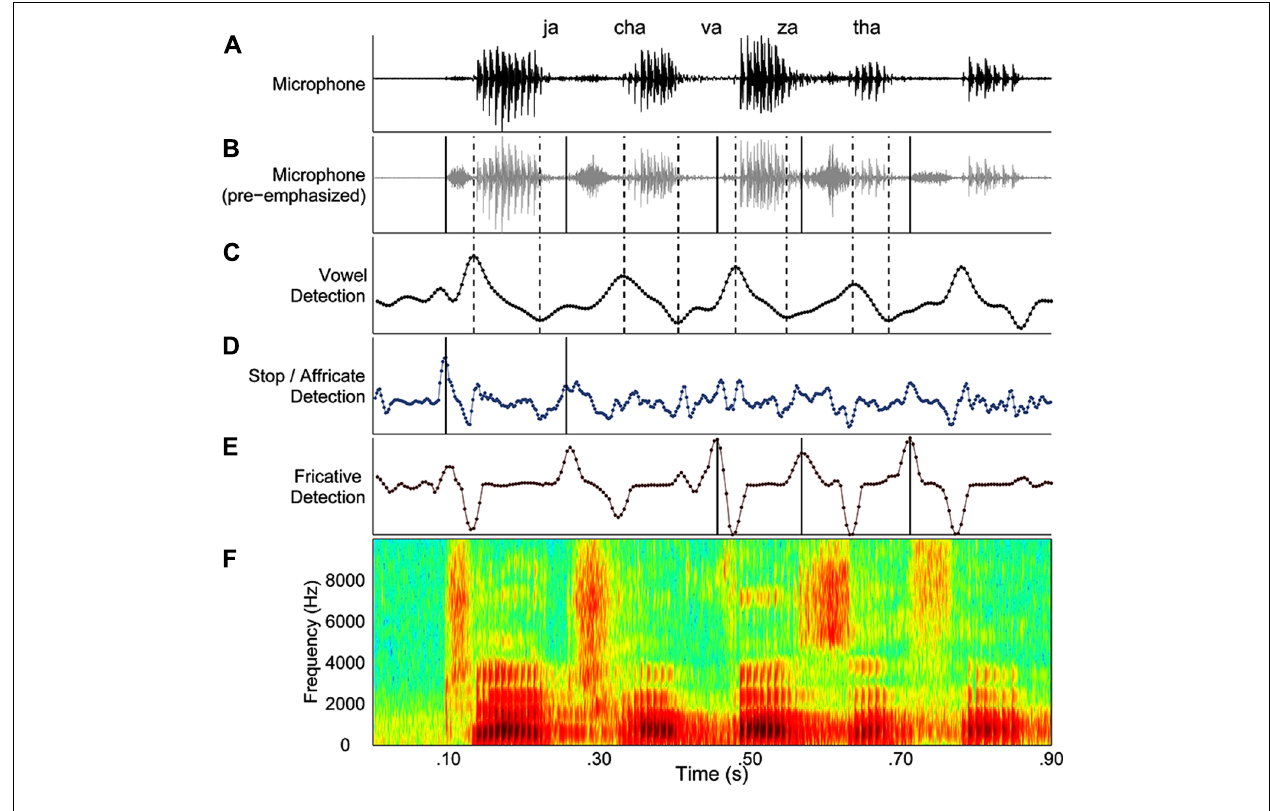
broadband spectrogram of the speech sequence produced by the speaker. Dashed lines indicate vowel onsets and vowel offsets in the “vowel detection” panel. Consonant onsets are indicated by solid lines in the panel corresponding to the manner of articulation for each consonant.